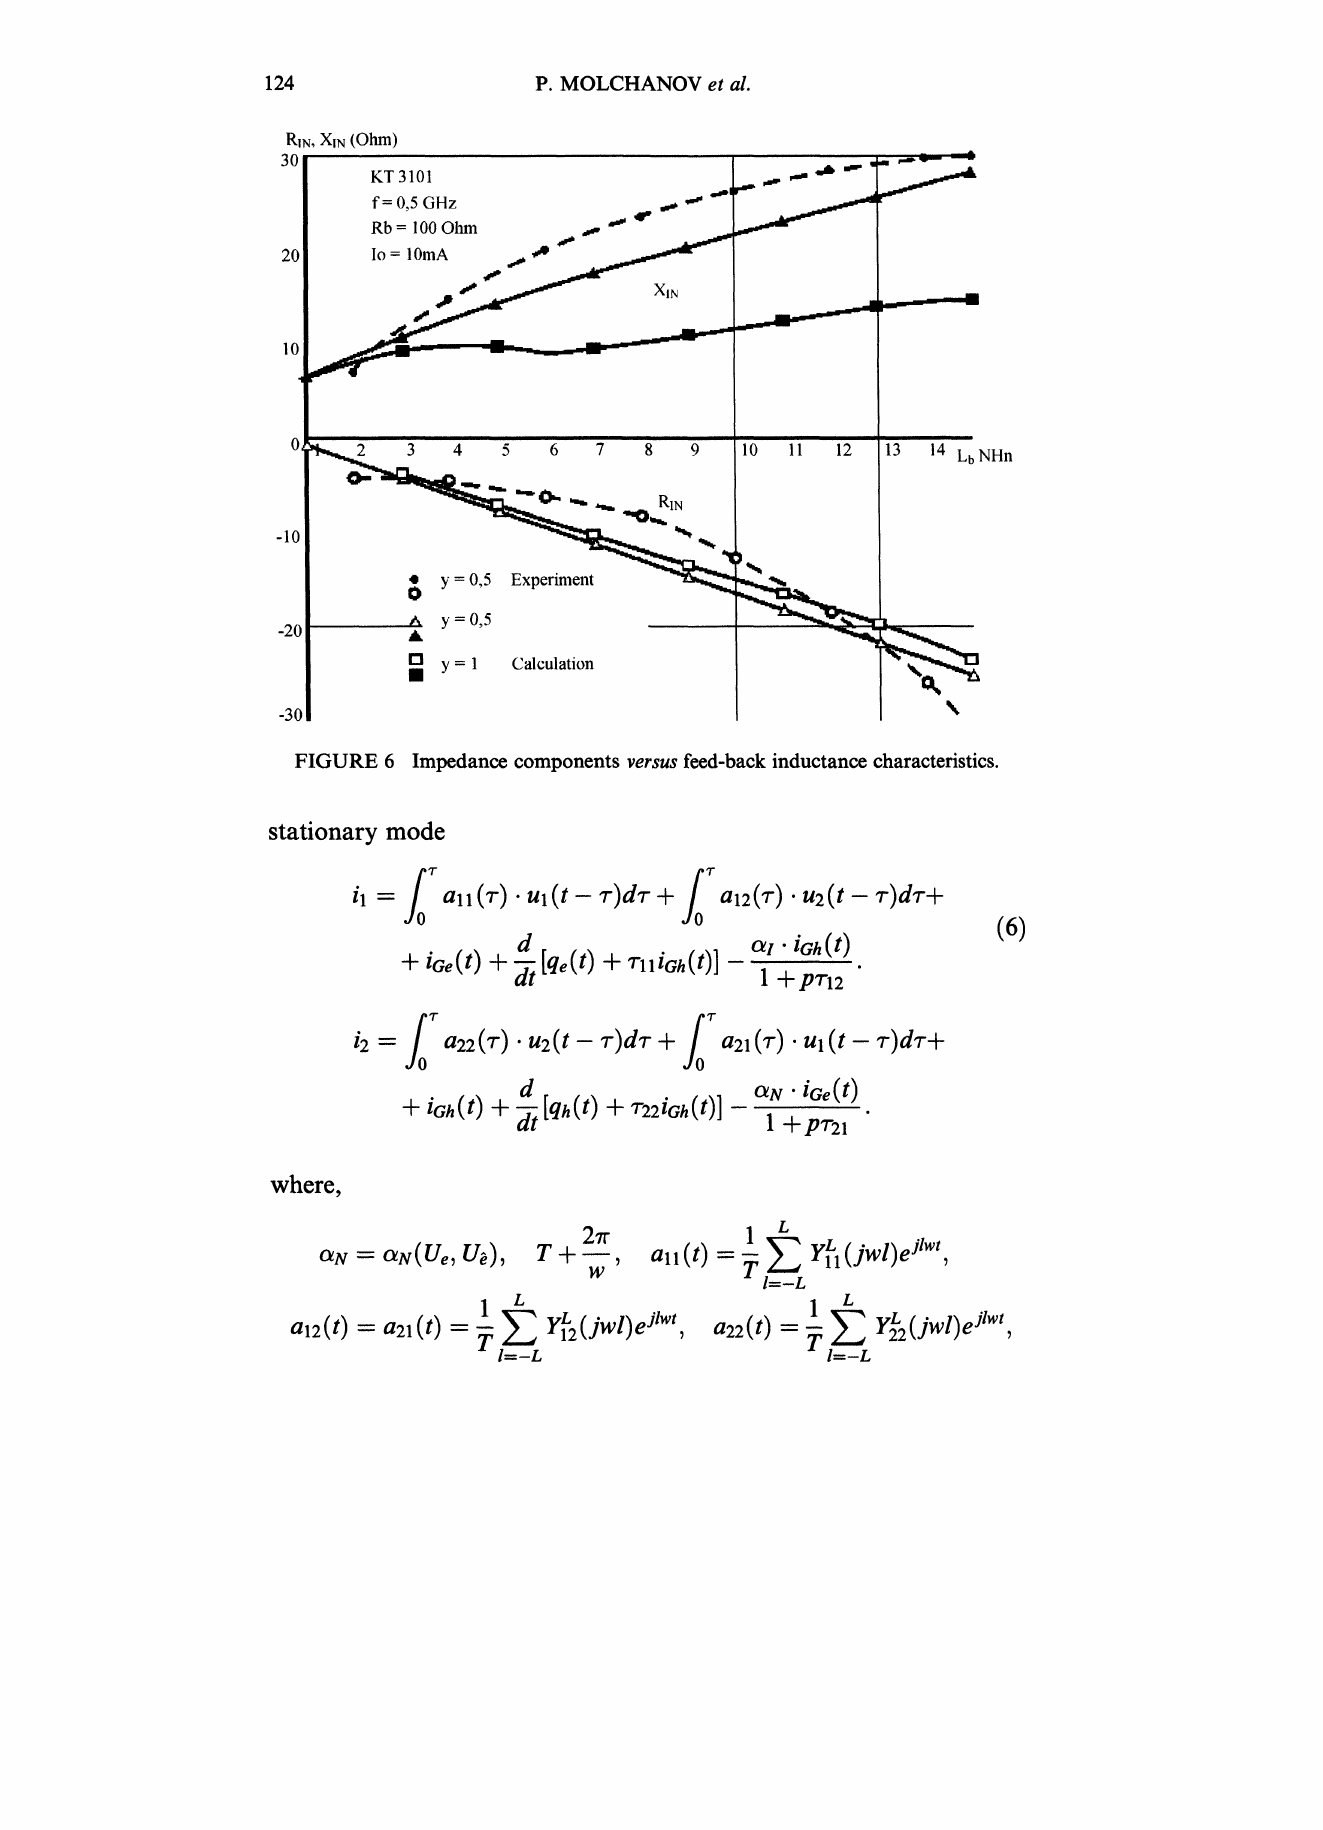
FIGURE 6 Impedance components versus feed-back inductance